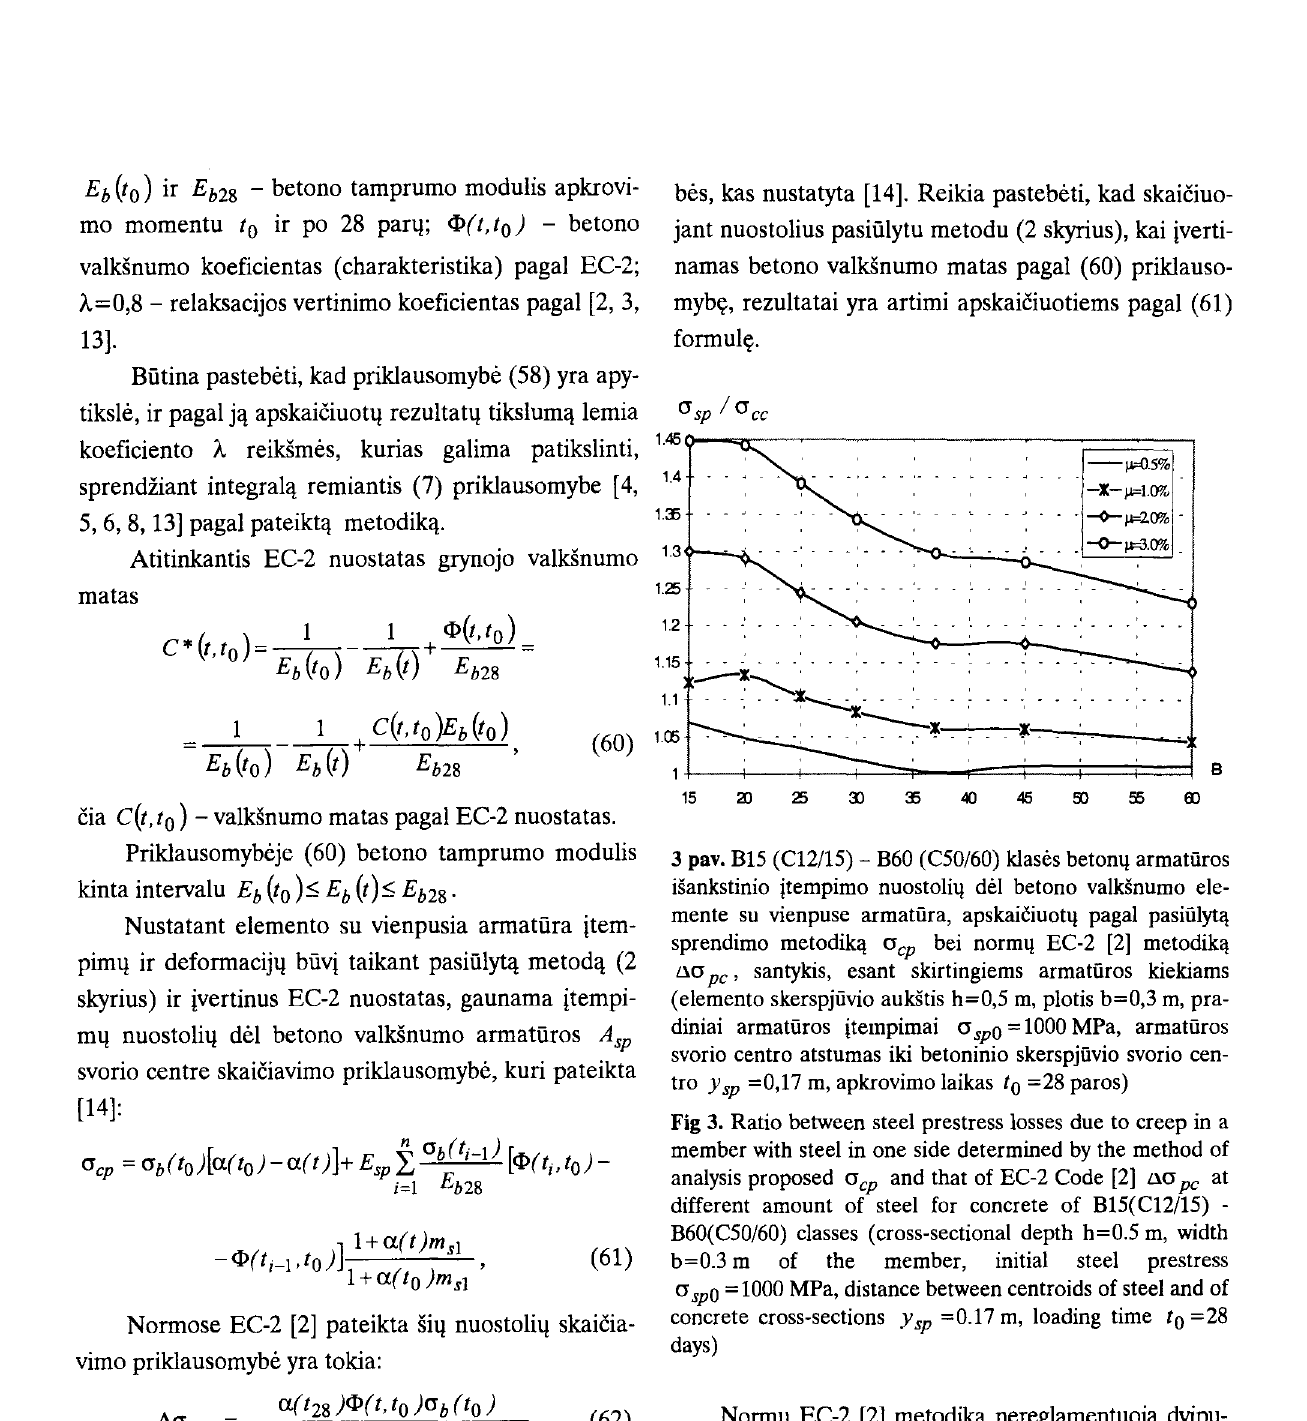
siskai armuotl) elementl) isankstinio armatiiros itempimo nuostoli4 del betono valkSnumo skaiciavimo. Todel Cia siiiloma siq metodikq